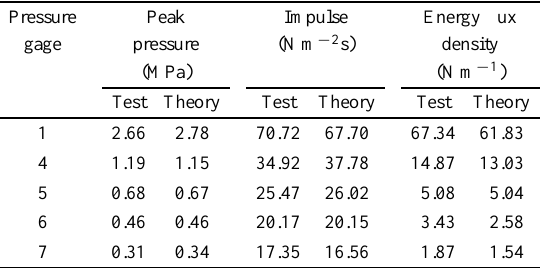
Comparison between average experimental observations and predic- tions of shock wave pulse characteristics along the axis of